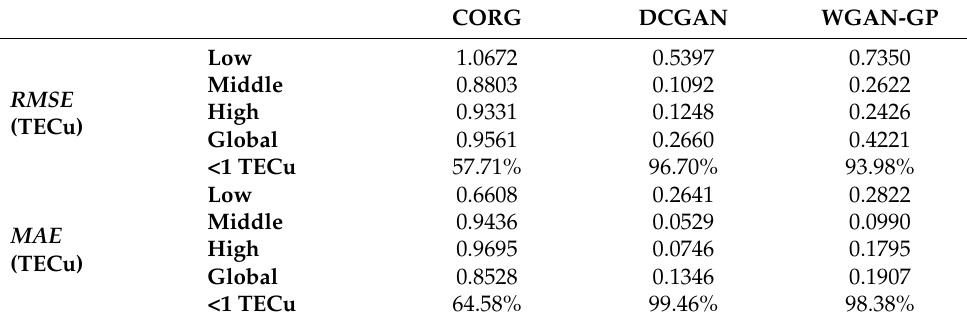
Figure 4. The RMSE and MAE for spatial TEC estimation in 2009. The 71 × 73 grids are interpolated with a spline to demonstrate a finer global feature of ionospheric TEC . Table 1. The mean values for RMSE and MAE in 2009.